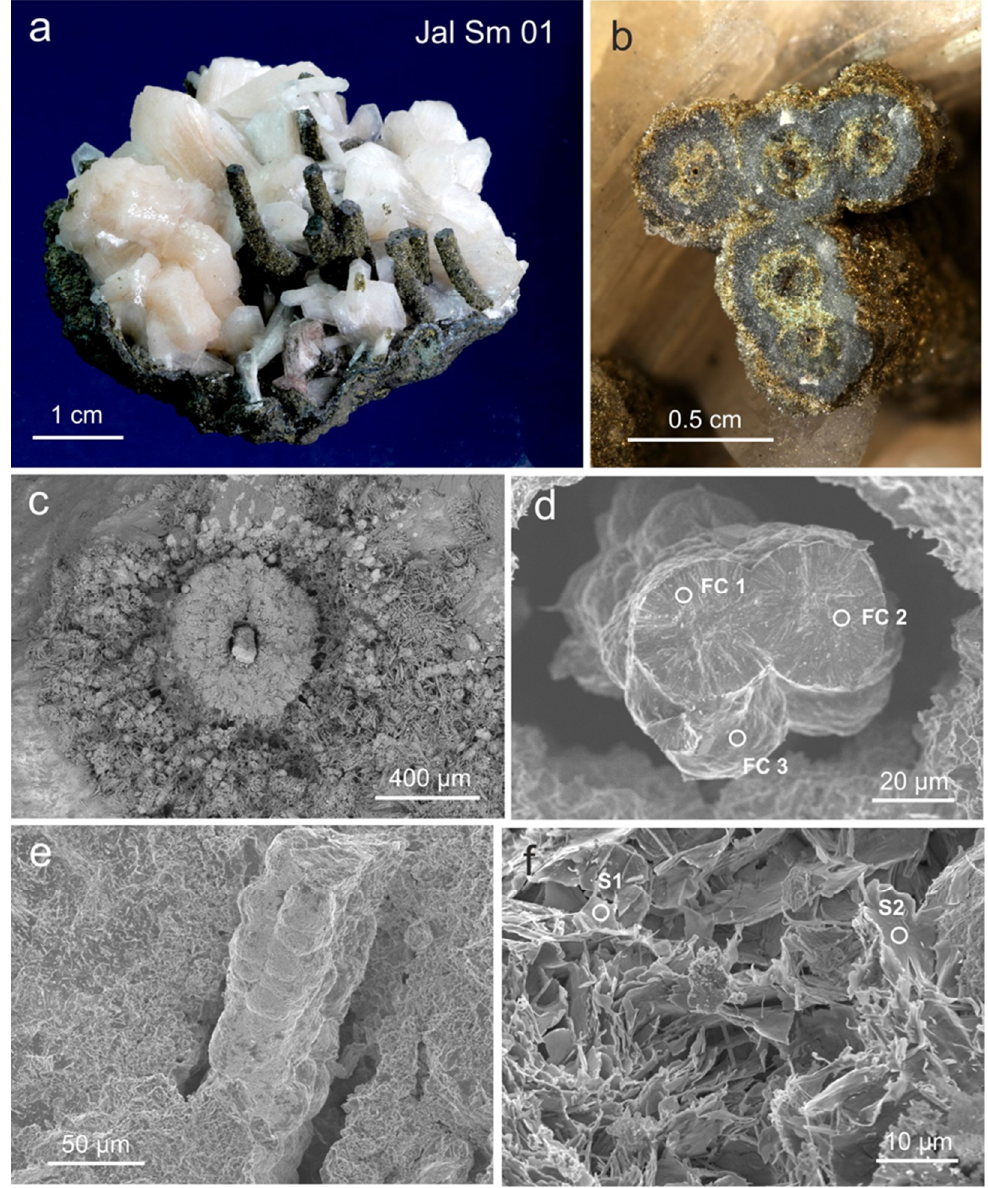
Figure 14. Images of sample Jal Sm 01 (Jalgaon/Savda): ( a ) secondary cavity mineralization showing brown filament aggregates between stilbite crystals; ( b ) cross-cut of the filamentous aggregates showing alternating greenish, brownish, and grey concentric layers; ( c ) SEM micrograph of a filamentous core with a thin innermost filament-like structure concentrically surrounded by mineral aggregates; ( d ) details of the innermost filamentous core of ca. 50-µm thickness consisting of radial fibers (the numbers relate to local chemical analyses, see Table S4); note the empty space between the filamentous core and the following mineralization sequence; ( e ) SEM micrograph showing a lateral view of the filamentous core; ( f ) close-up of the surface of the filamentous core showing a frame of flaky crystals of smectite (saponite; compare chemical composition in Table S4).